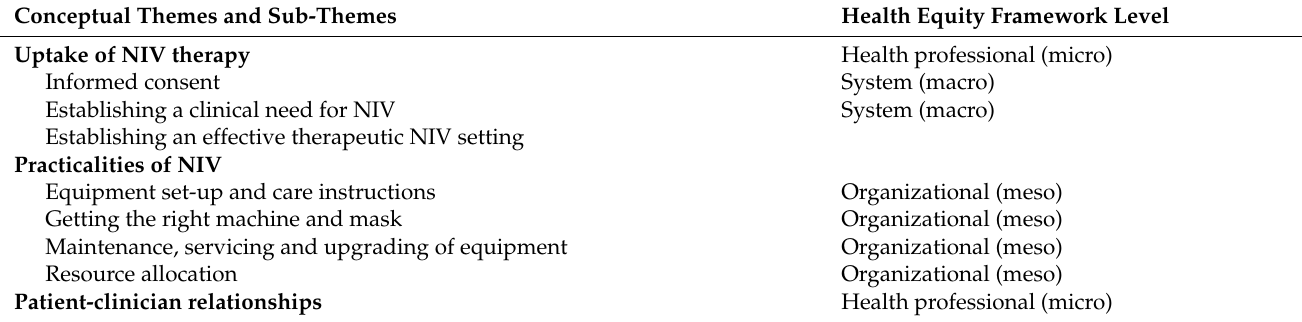
Table 2. Themes and Sub-themes mapped to the Health Equity